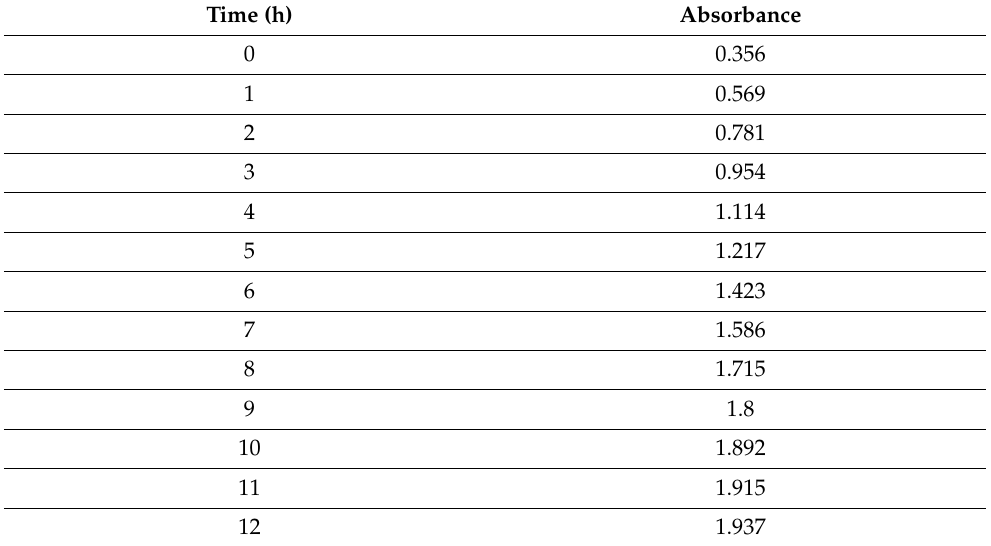
Table 1. Visual observation of AgNPs with time.